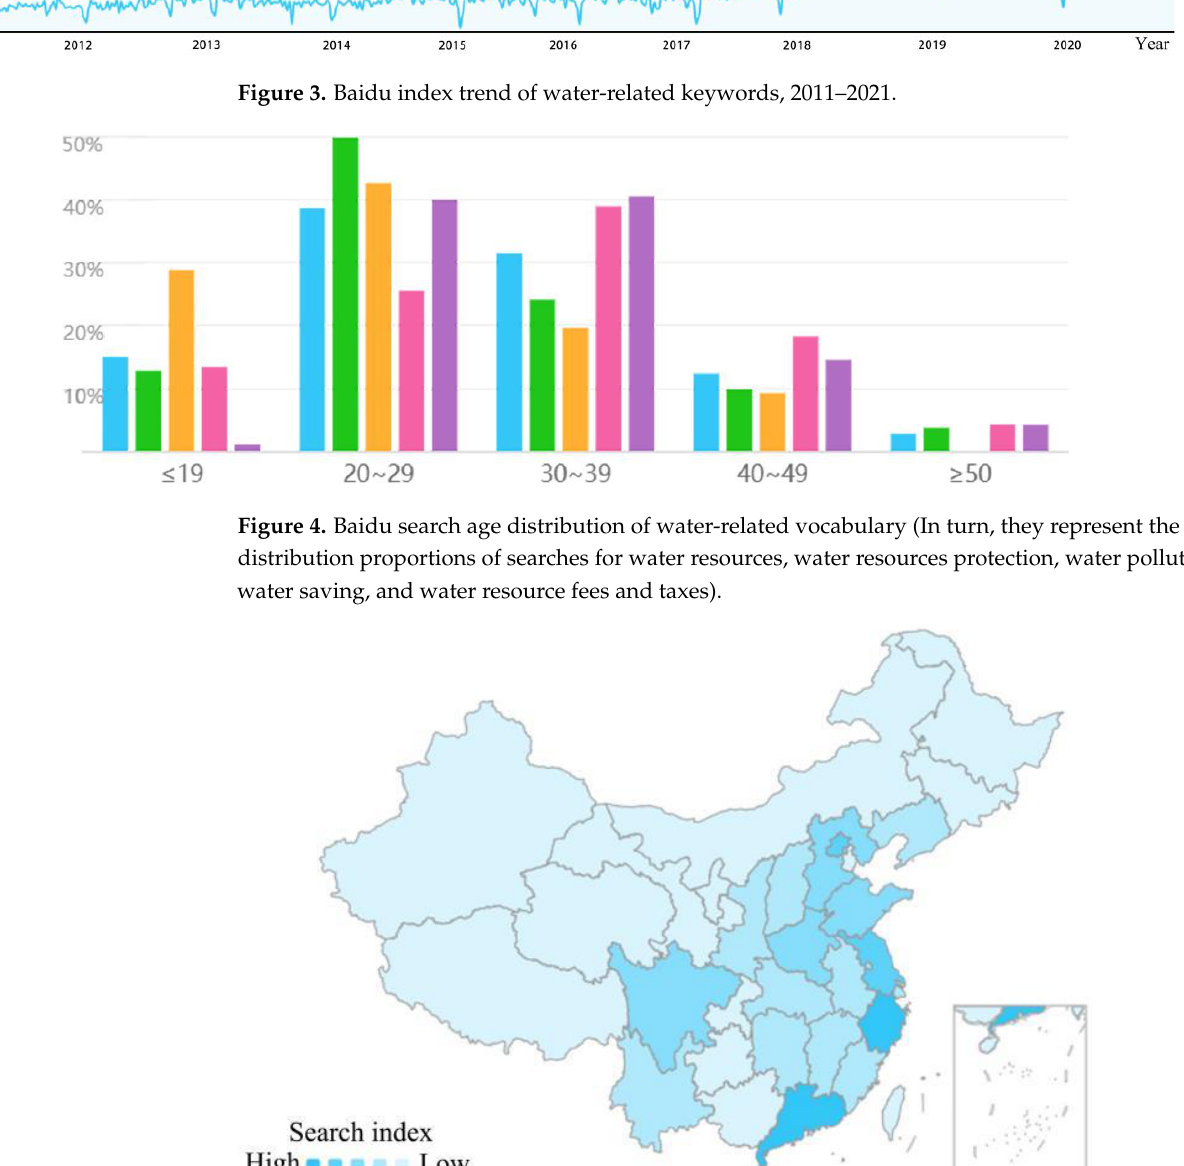
Figure 3. Baidu index trend of water-related keywords, 2011 – 2021.